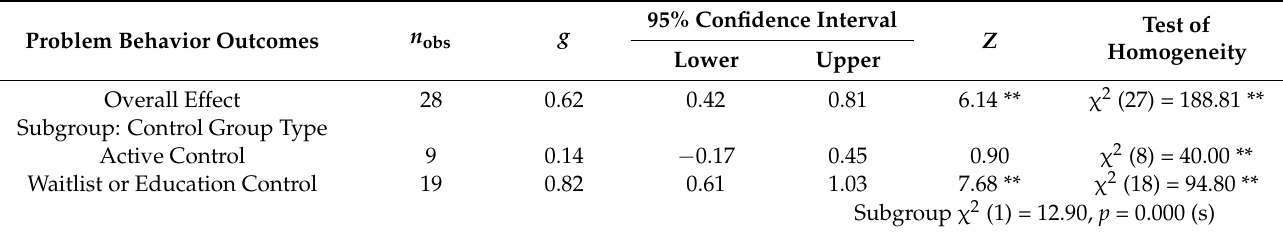
Table 3. Effect size outcomes for waitlist versus active control